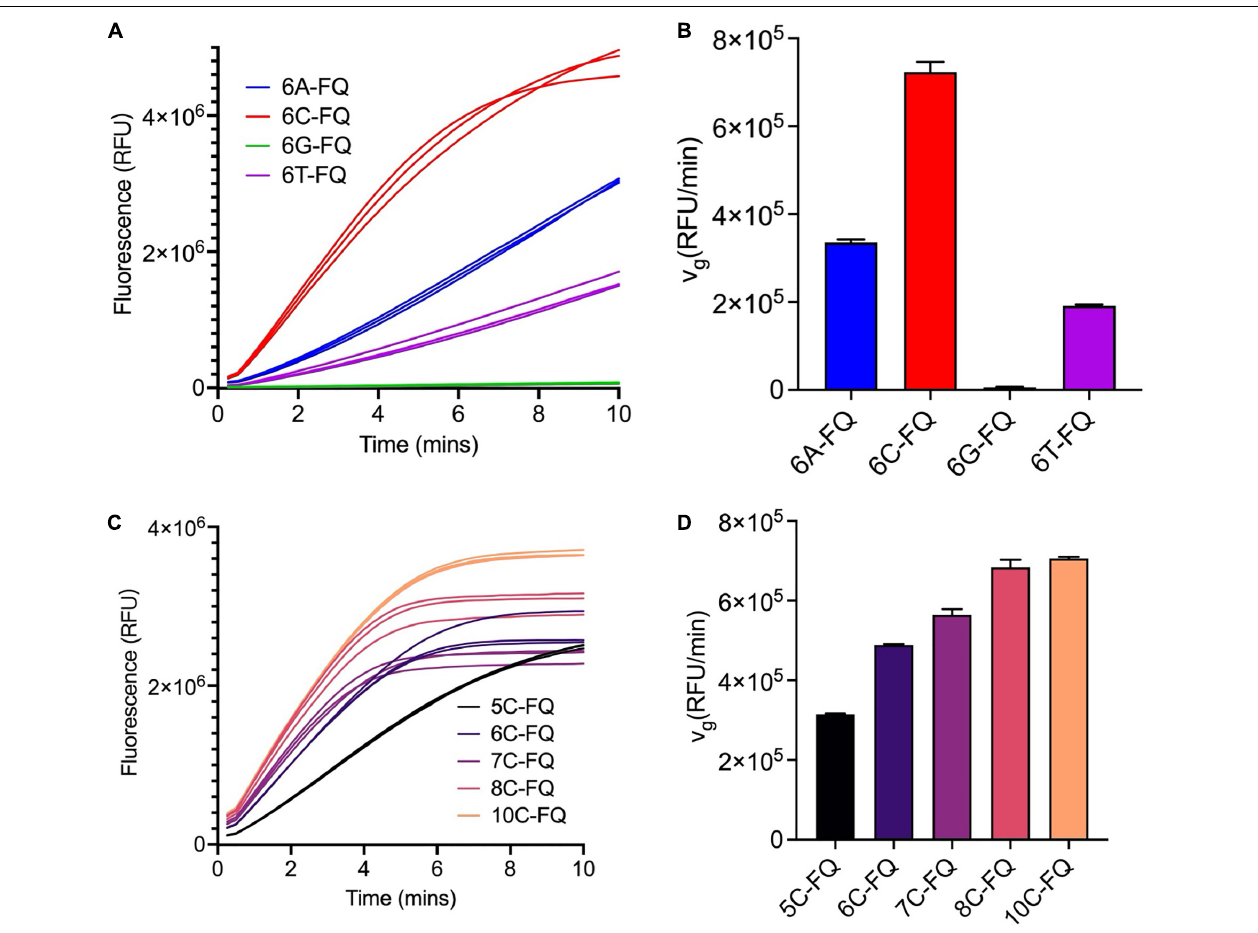
FIGURE 1 | Optimization of the ssDNA reporter sequences. (A) Fluorescence curves of the Cas12a trans -cleavage reactions using different ssDNA reporter sequences. The reaction systems were comprised of 250 nM crRNA, 250 nM Cas12a, 3 nM target dsDNA, 1000 nM reporter and 1 × NEBuffer 3.1. (B) Initial fluorescence growth rate of the reporters used in panel (A) . (C) Fluorescence curves of the Cas12a trans -cleavage reactions using poly-C ssDNA reporters of different lengths. The reaction systems were comprised of 250 nM crRNA, 250 nM Cas12a, 3 nM target dsDNA, 800 nM reporter, and 1 × NEBuffer 3.1. (D) Initial fluorescence growth rate of the reporters used in panel (C)